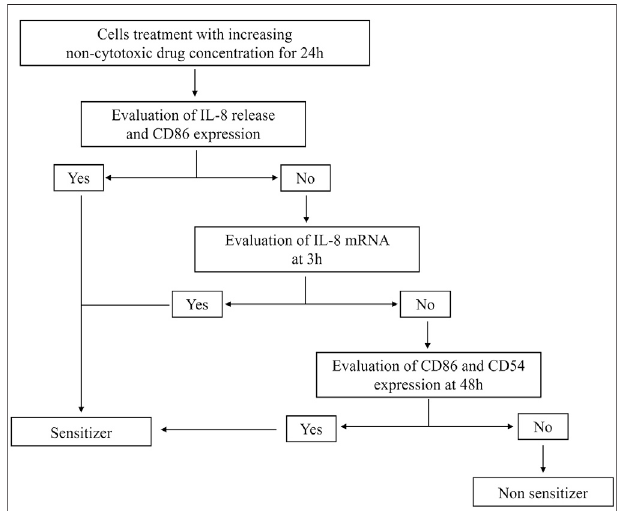
FIGURE1| Modi fi edTHP-1activationassayforthehazardidenti fi cation of potential drug sensitizers. Graphical representation of the modi fi ed THP-1 activation assay protocol to derive the potential about sensitizing or non- sensitizing information of drugs.